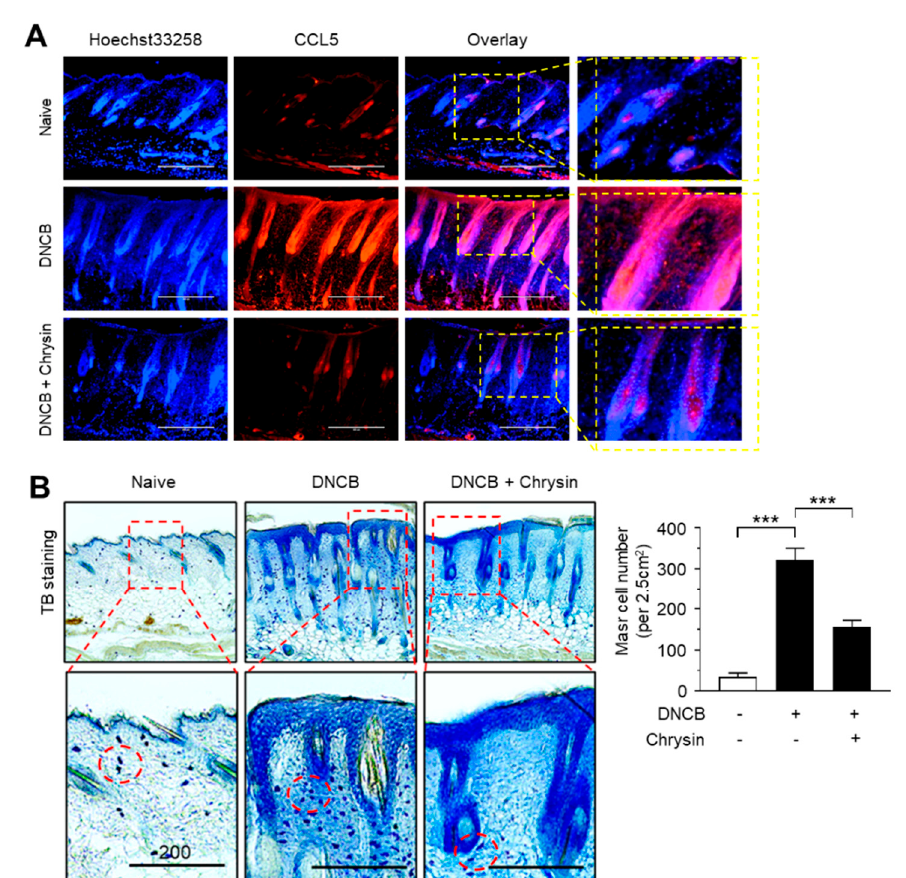
Figure 6. Effect of chrysin on the suppression of CCL5 expression and the infiltration of mast cells in DNCB-induced skin lesions. ( A ) Immunofluorescence staining of CCL5 using rhodamine red-X-conjugated secondary antibody (red) in skin tissues treated with DNCB and DNCB + 0.2% chrysin. Nuclei were counterstained using Hoechst 33258 (blue). Scale bar, 400 µ m. Magnified view of the areas in the dashed boxes are provided in the right panels. ( B ) Mast cells were stained with 0.1% toluidine blue in skin tissues treated with DNCB and DNCB + chrysin (25 mg/kg). The areas in the dashed boxes are enlarged in the bottom panels. The dotted circles indicate the infiltrating mast cells (blue spots). Scale bar, 200 μ m. The number of mast cells per 2.5 cm 2 of area was counted. Graph data are expressed as the mean ± SD ( n = 5). *** p < 0.0001 by Dunnett’s multiple comparisons test.